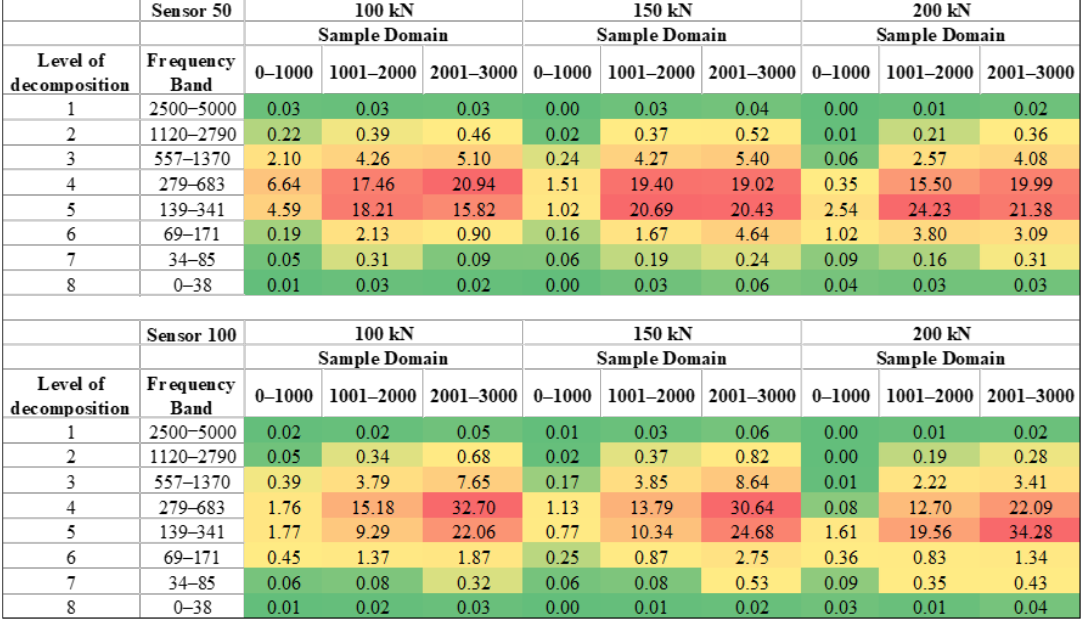
Figure 17. Comparison of relative energy generated through MODWT of signals for various loads. [Colour gradient: red to green corresponds to high to low relative energy].